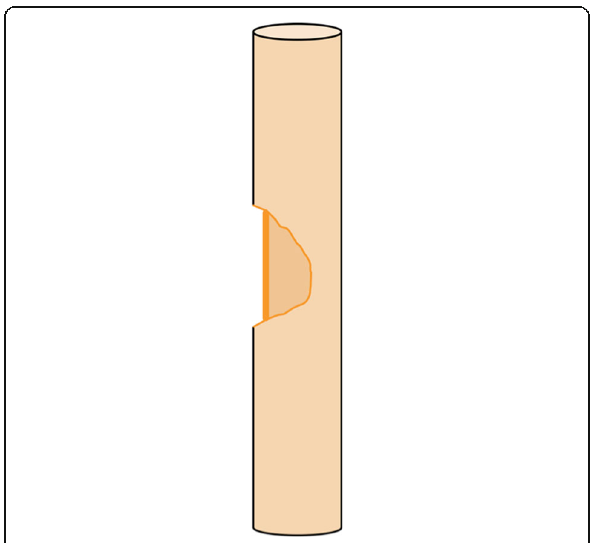
Fig. 3 Schematic representation of a B0 fracture type according to a modified Müller AO classification used in the present study